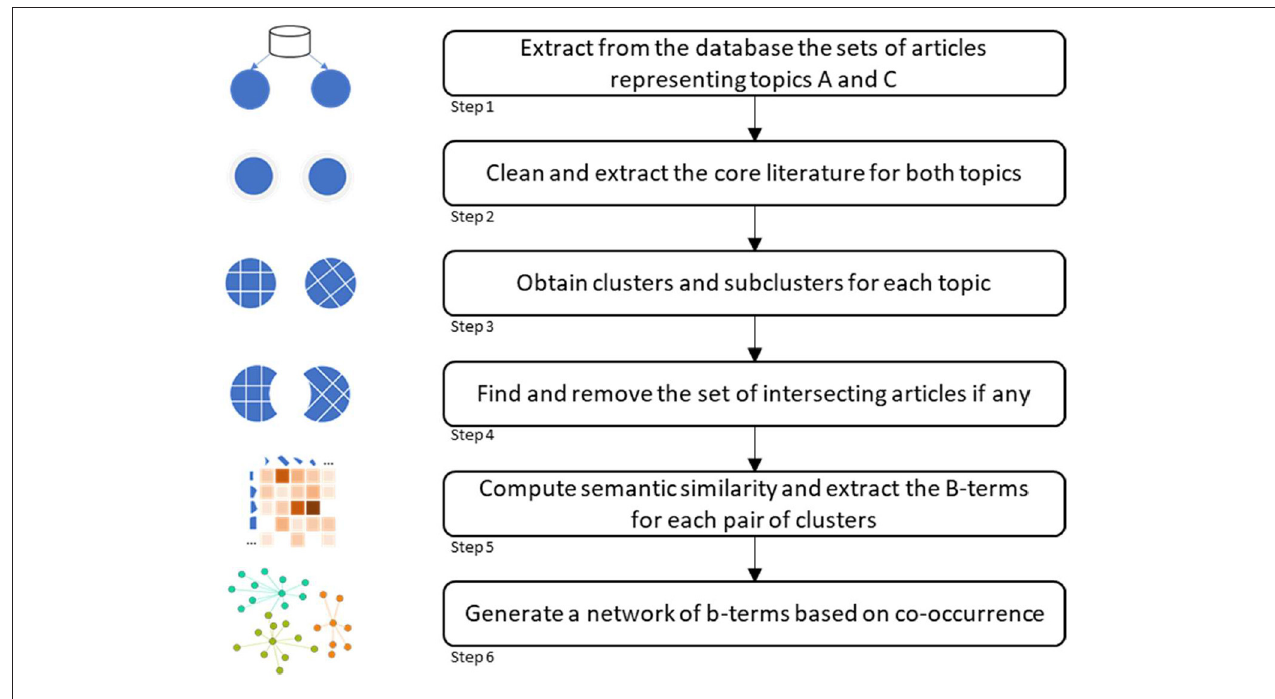
FIGURE 1 | Overview of the methodology.